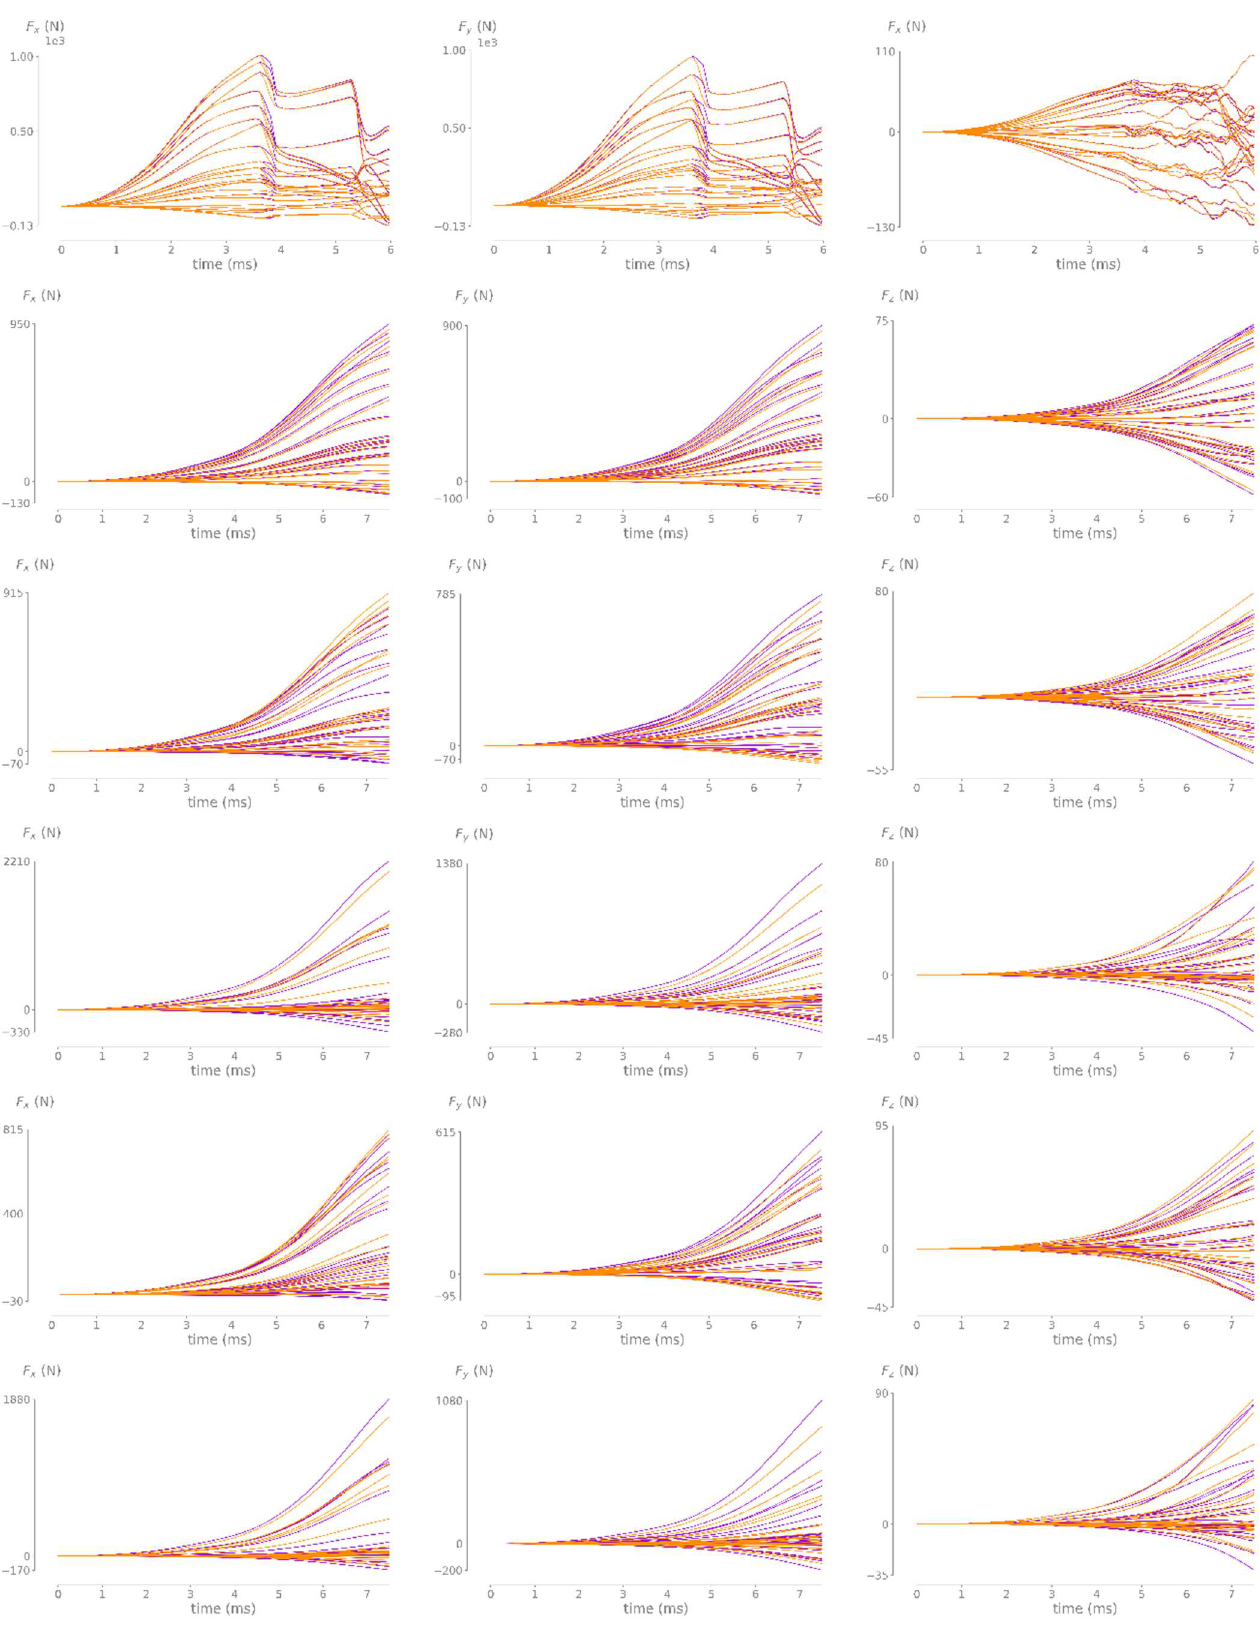
Fig. 26. Predicted forces for the loadings belonging to the test set (images at each row refers to a different loading condition): (left) F x ; (center) F y ; and (right) F z